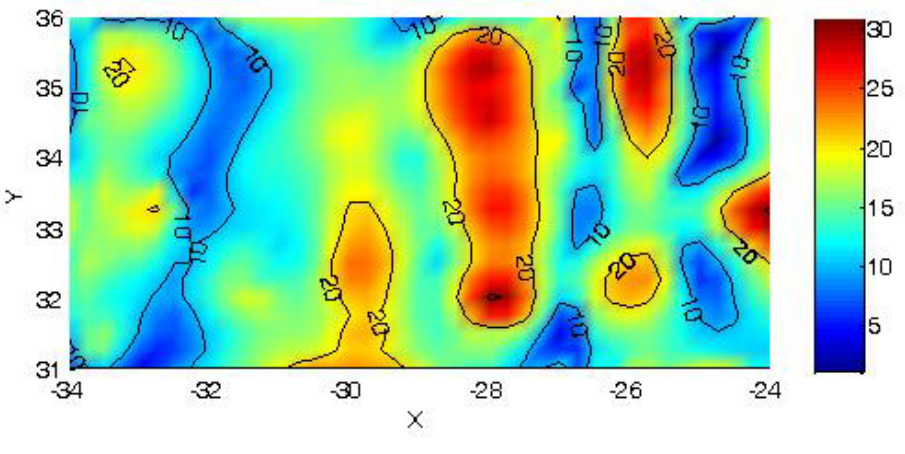
Figure 5. Magnetic anomalies in the second sector with precise geometry. Units in